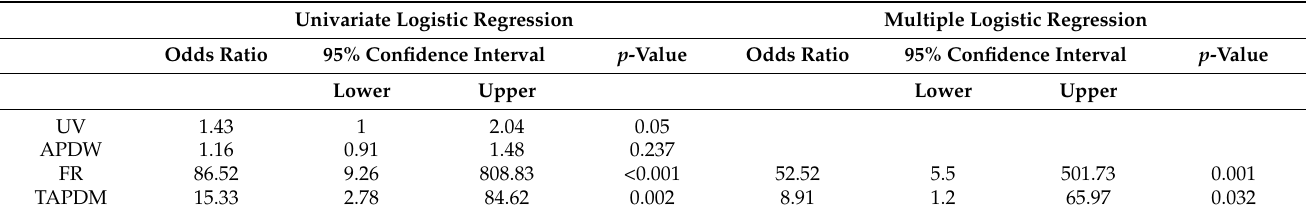
Table 7. Univariate logistic regression analysis and multiple logistic regression analysis using stepwise backward elimination.